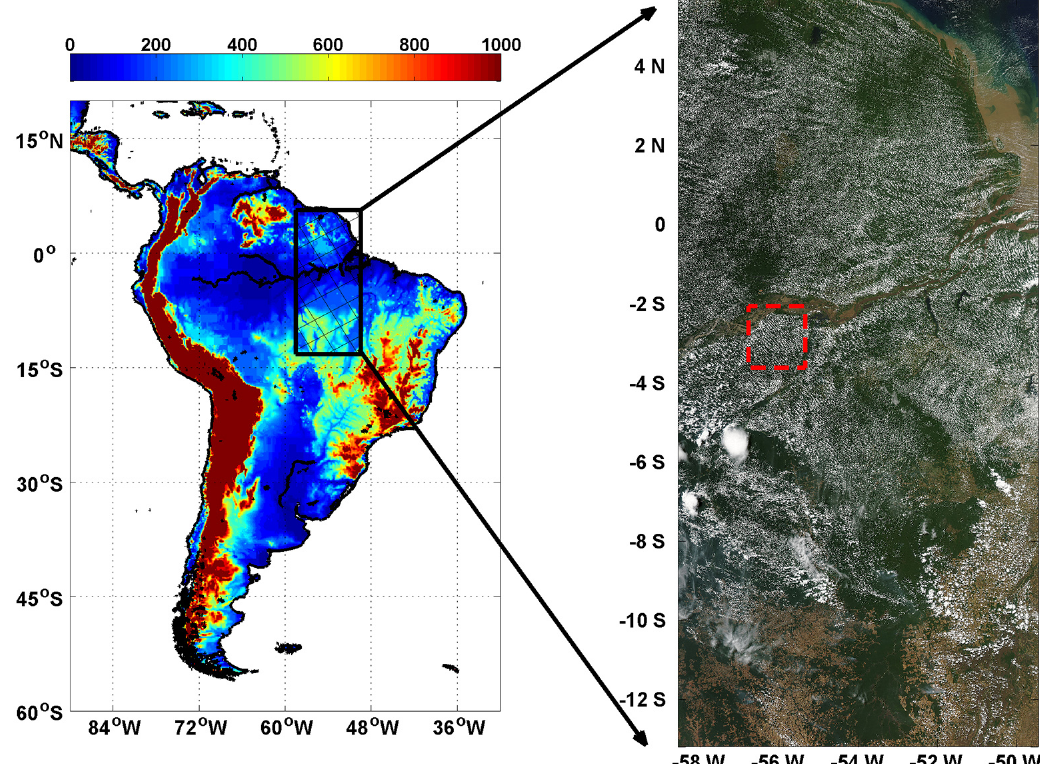
Figure 1. Left: topographic map of South America (note that the color bar is capped at 1000m); study region indicated by cross-hatched box. Map based on ETOPO1 1arcmin global relief model data set (Amante and Eakins, 2009). Right: typical forest cumulus (FCu) fields over the Amazon Basin study region. GeoTIFF image taken from MODIS Rapid Response USDA Foreign Agricultural Service (FAS) subsets. The dashed red box indicates the area magnified in Fig. 2. Image corresponds to 1 September 2011, 13:30LST. The Amazon River and its tributaries inhibit all types of cloud